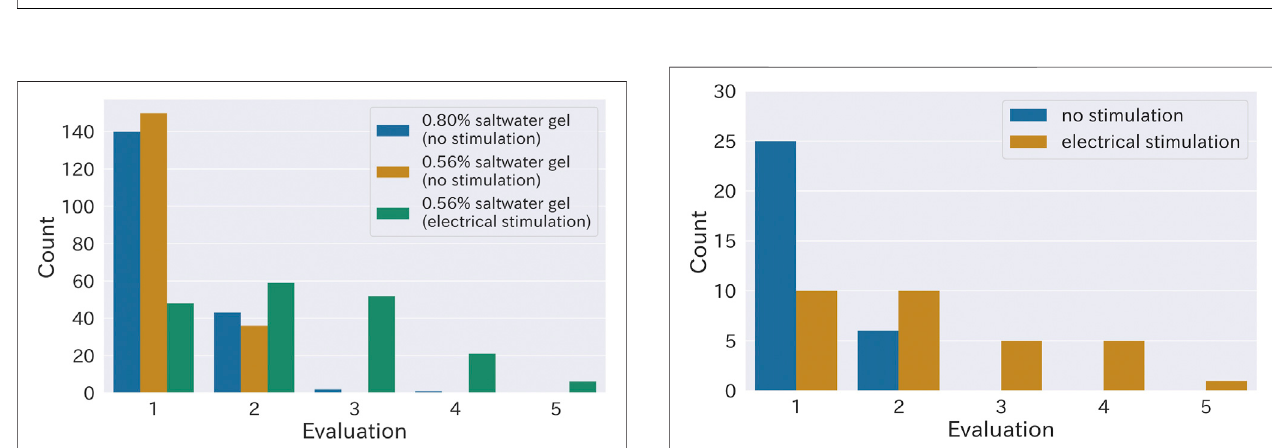
Frontiers in Virtual Reality |